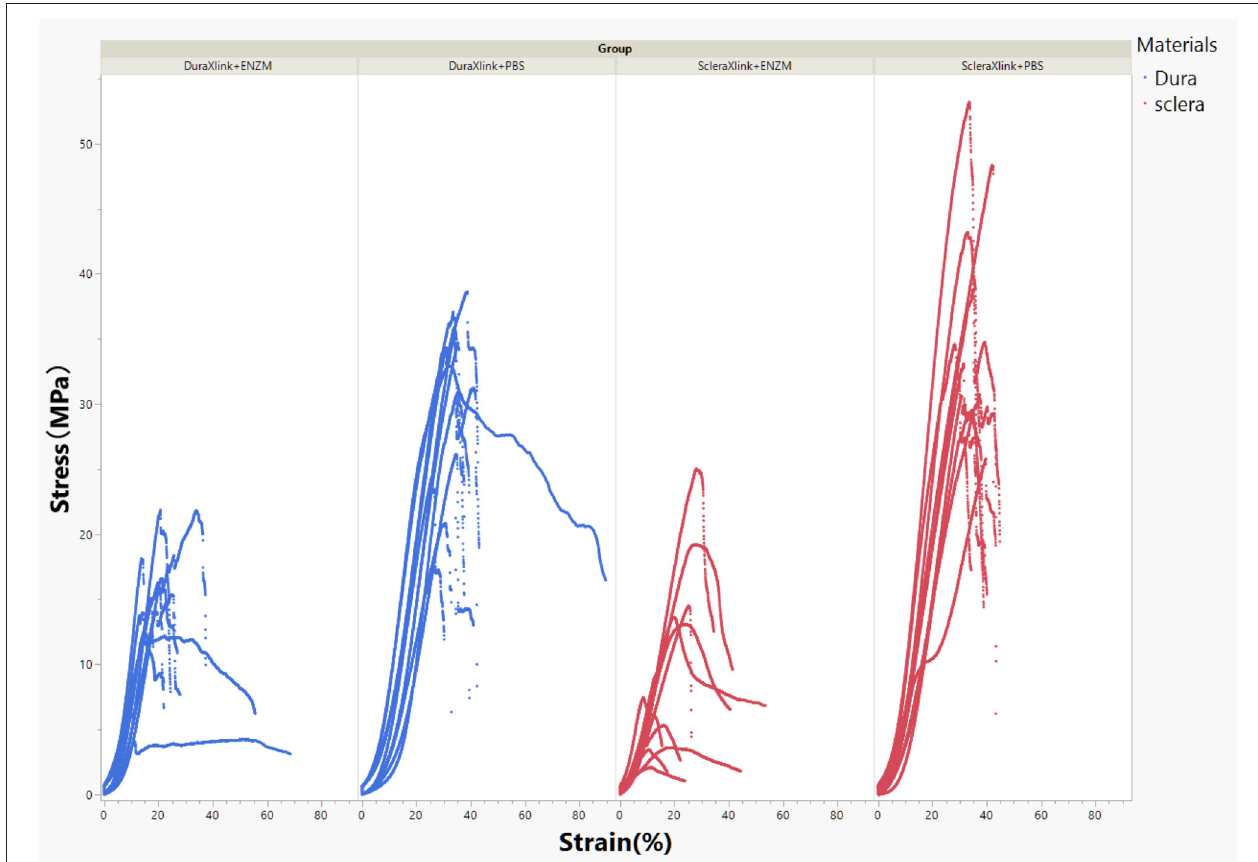
FIGURE 4 | Stress–strain curves of crosslinked human sclera or dura after 11 days of exposure to enzymatic solution or to PBS. DuraXlink, crosslinked dura; ScleraXlink, crosslinked sclera; PBS, phosphate buffered saline; ENZM, protease XIV, 1 U/ml with 1% penicillin-streptomycin.